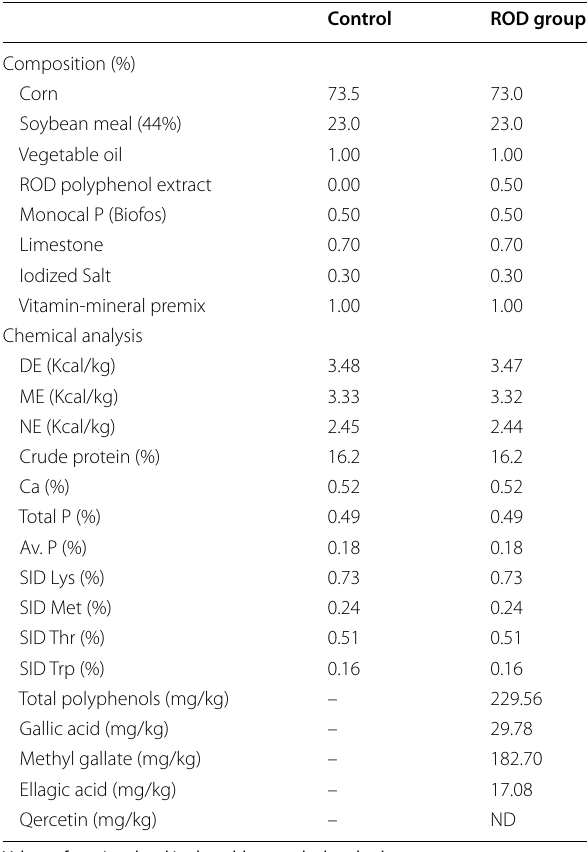
ROD polyphenol extract supplemented